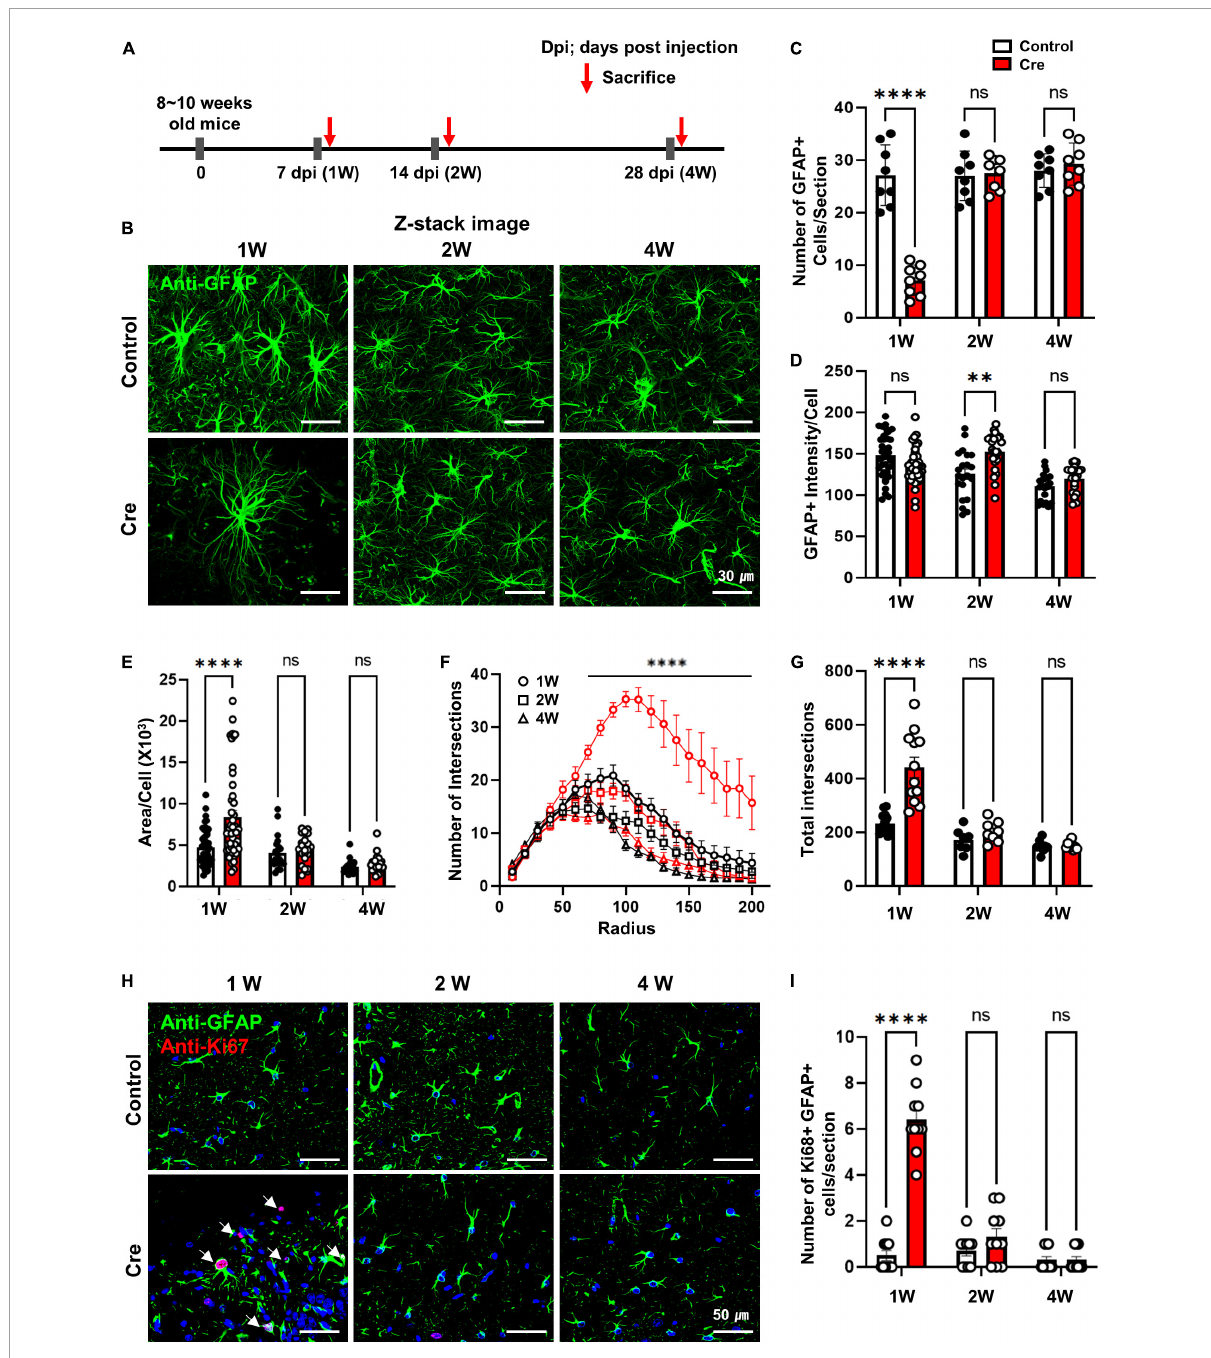
FIGURE2 Induction of apoptosis with Cre in hippocampal astrocytes of active caspase-3 cTg mice. (A) A diagram showing the timeline of experimentation. (B) Following the administration of AAV-GFAPp-HA-BFP-Control or HA-BFP-Cre virus, slice tissue of brain in cTg mice were performed to immunostaining to analyze the expression of GFAP-positive astrocytes; Anti-GFAP (green); Z-stack imaging. (C) The number of GFAP-positive cells per section (# of sections = 8). ( D,E ) Analyze the area and intensity of GFAP-positive cells per single cell (1W; control n = 46, Cre n = 45, 2W; control n = 21, Cre n = 24, 4W; control n = 21, Cre n = 24). (F) The number of intersections per radius (in 200 µ m) using the sholl analysis (1W; control n = 14, Cre n = 12, 2W; control n = 7, Cre n = 8, 4W; control n = 8, Cre n = 9). (G) The total number of intersections (in 200 µ m) using the sholl analysis (1W; control n = 14, Cre n = 12, 2W; control n = 7, Cre n = 8, 4W; control n = 8, Cre n = 8). (H) Following the administration of AAV-GFAPp-HA-BFP-Control or HA-BFP-Cre virus, slice tissue of brain in cTg mice were performed to immunostaining to analyze the expression of Ki67 in GFAP-positive astrocytes; Anti-GFAP (green), anti-Ki67 (red). (I) Number of GFAP-positive and Ki67-positive cells per sections (# of sections = 10). Data are represented as the means ± SEM ( ∗∗∗∗ p < 0.00001 according to two-way ANOVA and Turkey’s test, ns; not